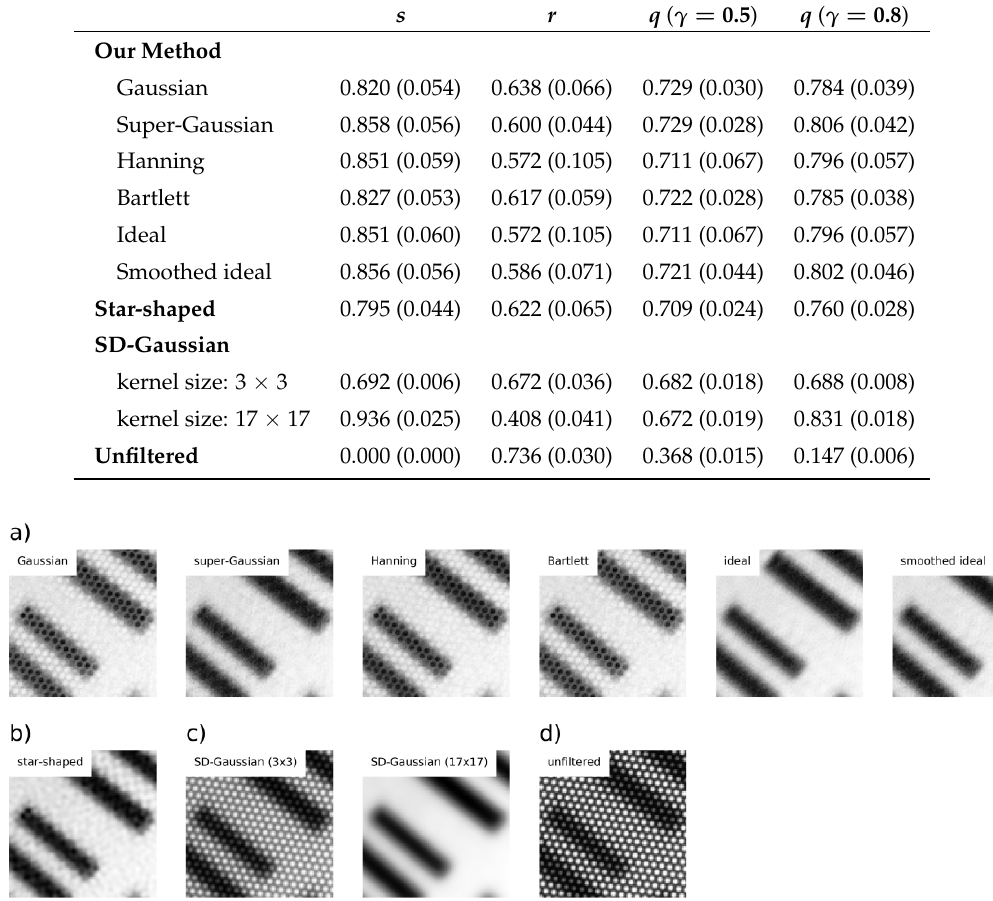
Figure 5. Test chart displayed in detail at wavelength 510 nm for ( a ) our method using different filters; ( b ) star-shaped filtering ( c ) filtering in the SD using Gaussian filtering with two different kernel sizes and ( d ) the unfiltered